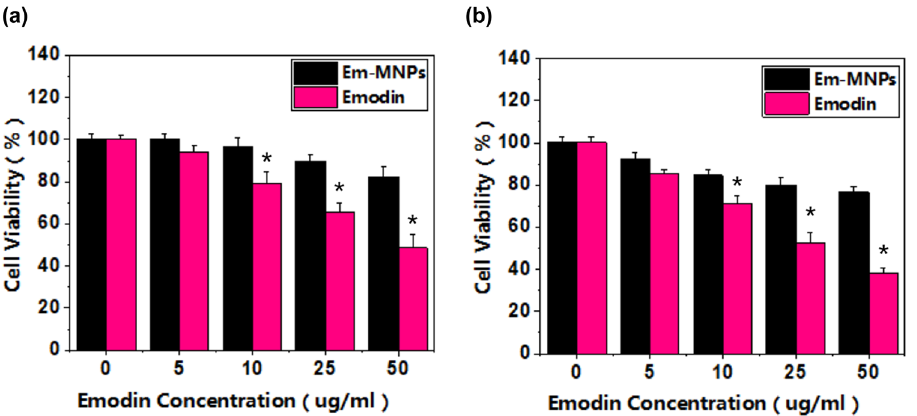
Figure 6: Cytotoxicity assay. Cell viability of rat proximal tubular cells treated with emodin ( 0 – 50 µg/mL ) and Em - MNPs ( equivalent to 0 – 50 µg/mL emodin ) for 12 h ( a ) and 24 h ( b ) , respectively. * p < 0.05 versus the Em - MNPs group.